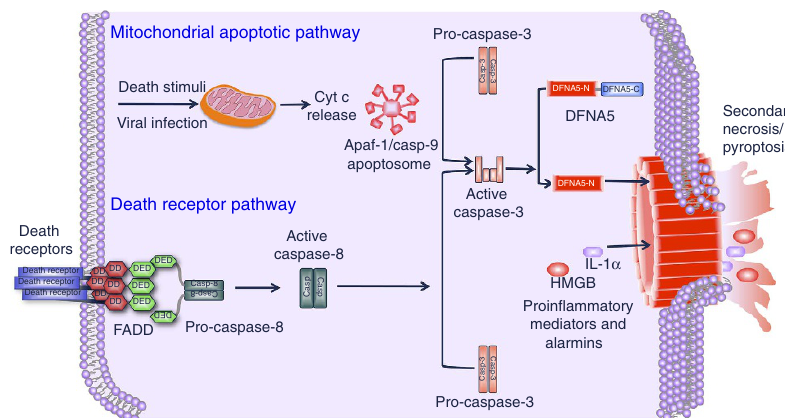
Figure 9 | Signalling pathways leading to activation of DFNA5. Various death stimuli or viral infection can lead to permeabilization of the outer mitochondrial membrane causing the release of cytochrome c, which binds to Apaf-1 leading to assembly of the Apaf-1 apoptosome and activation of caspase-9. Within this complex active caspase-9 cleaves procaspase-3 to generate the active caspase-3 heterodimer. Active caspase-3 in turns cleaves DFNA5 at Asp270 to generate the necrotic DFNA5-N fragment which permeabilizes the plasma membrane by forming large pores causing osmotic lysis of the cell and releasing cellular contents including pro-inflammatory mediators and alamins, into the extracellular space. Caspase-3 can also be activated by the death receptor pathway, which is activated by death receptor ligands at the cell membrane. This pathway can potentially lead to caspase-3-mediated processing of DFNA5 and secondary